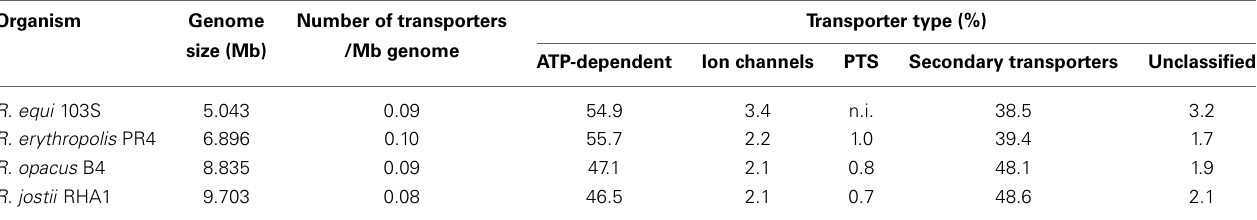
Table 1 | Distribution of the families of transporter systems in the genomes of four distinct Rhodococcus species (Transporter classification database, Saier et al., 2006; TransportDB, Ren et al., 2007).